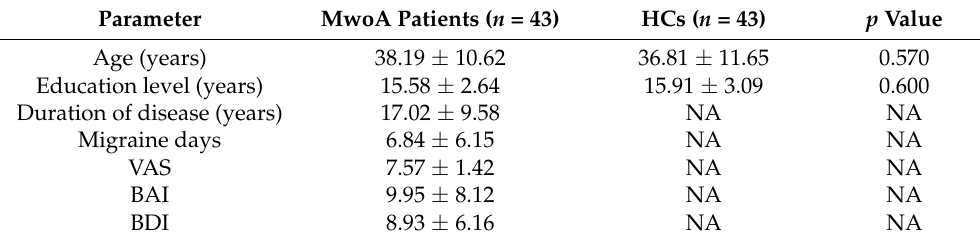
Table 1. Demographics and clinical data of female MwoA patients and HCs (mean ±